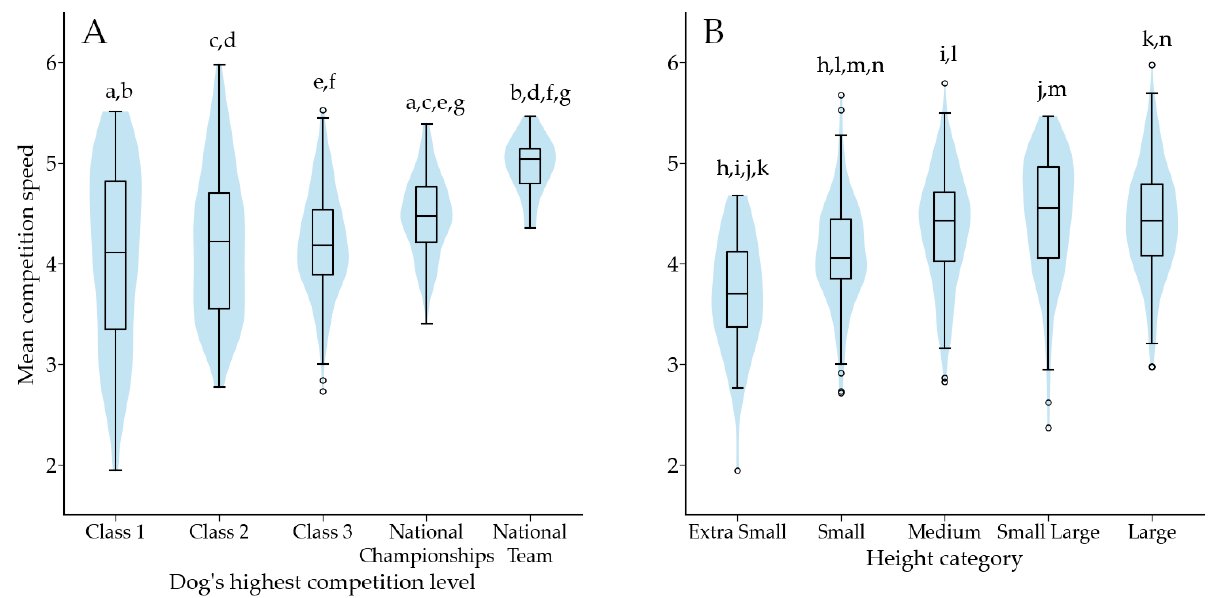
Figure 8. ( A ) Mean speed of faultless runs according to the dog’s highest competition level. ( B ) Mean competition speed according to the height category. Same letter indicates a significant difference between two competition levels or height categories. For letter a, p < 0.05, for letters g, h and l p < 0.01, for all other letters p < 0.001. Outliers are plotted as “ ◦ ”.